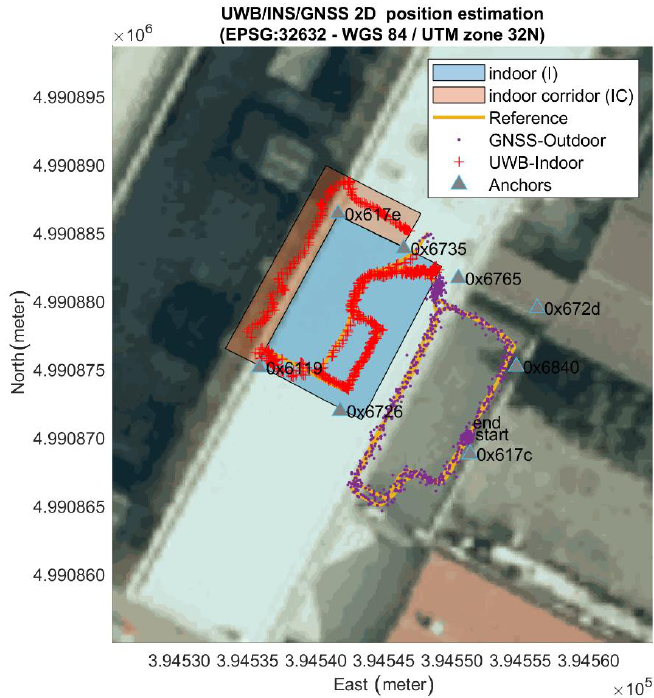
Figure 9. Pedestrian trajectory obtained by the proposed algorithm expressed in WGS84-UTM zone 32 N coordinates.